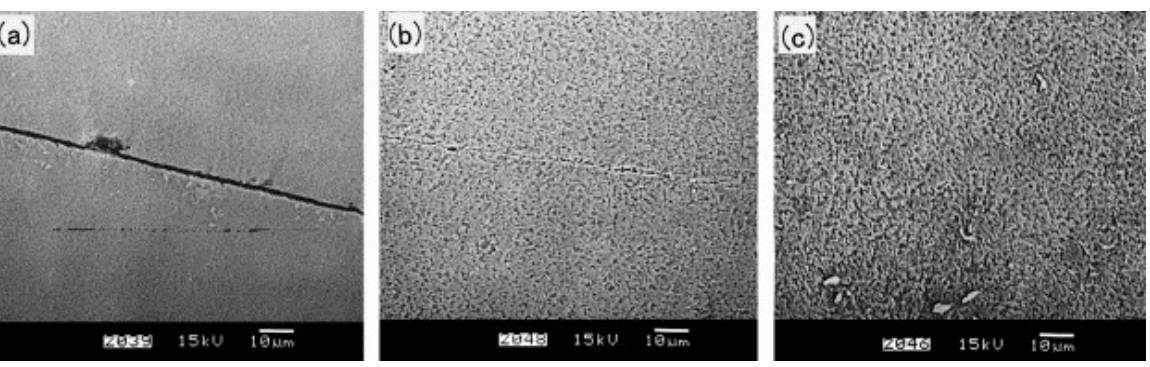
Figure 6. Microstructure of the interface at different stage uder a pressure of 60 MPa at 900 °C in 3.6 ks ( a ) the closure of long wavelength asperities; ( b ) the closure of short wavelength saperities and ( c ) the elimination of planar grain boundary interface and